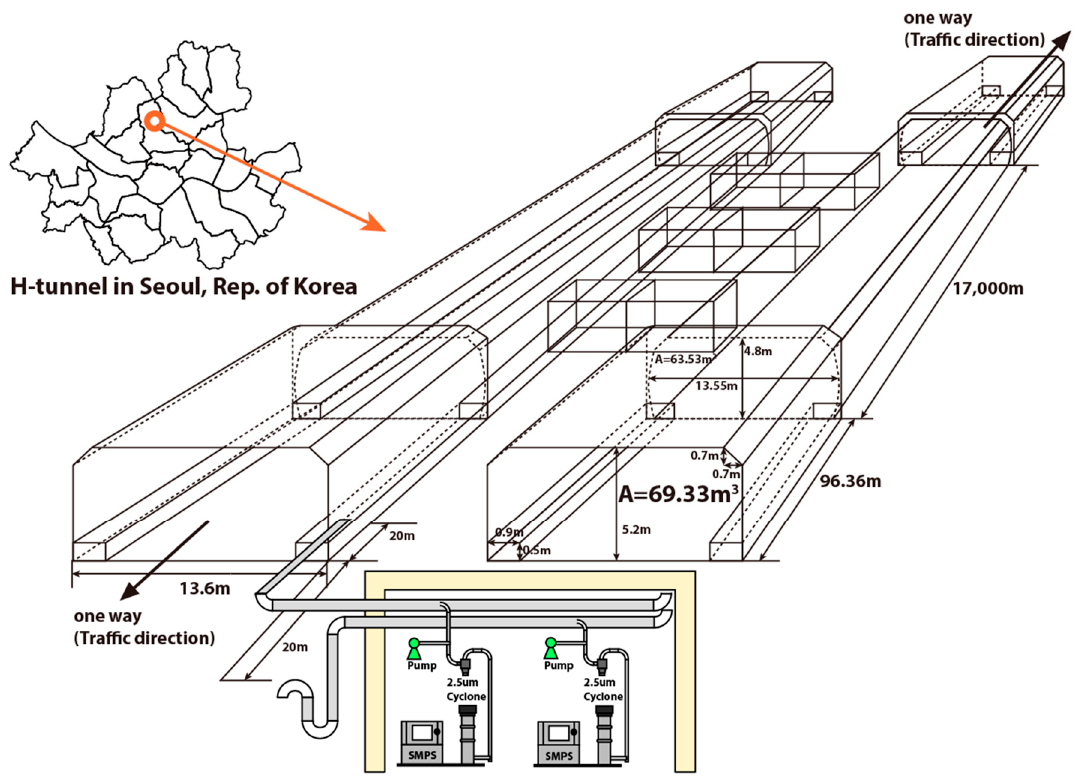
Figure 1. Diagram of H Tunnel located in Seoul, Republic of Korea.